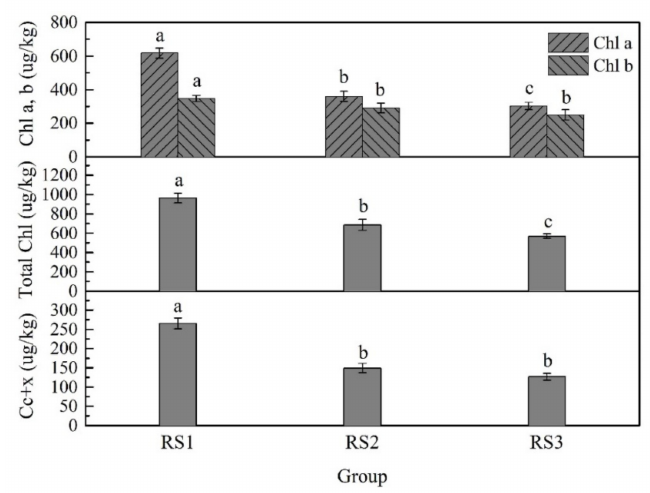
Figure 3. The change of pigments concentrations in Shine Muscat grape berries at di ff erent ripening stages: Chl a, Chlorophyll a; Chl b, Chlorophyll b; Total Chl, total Chlorophyll; and C c + x , total carotenoids. RS1, ripening stage 1; RS2, ripening stage 2; and RS3, ripening stage 3. All data represent mean ± SD. Di ff erent letters in the same category indicate a statistically significant di ff erence ( p < 0.05).